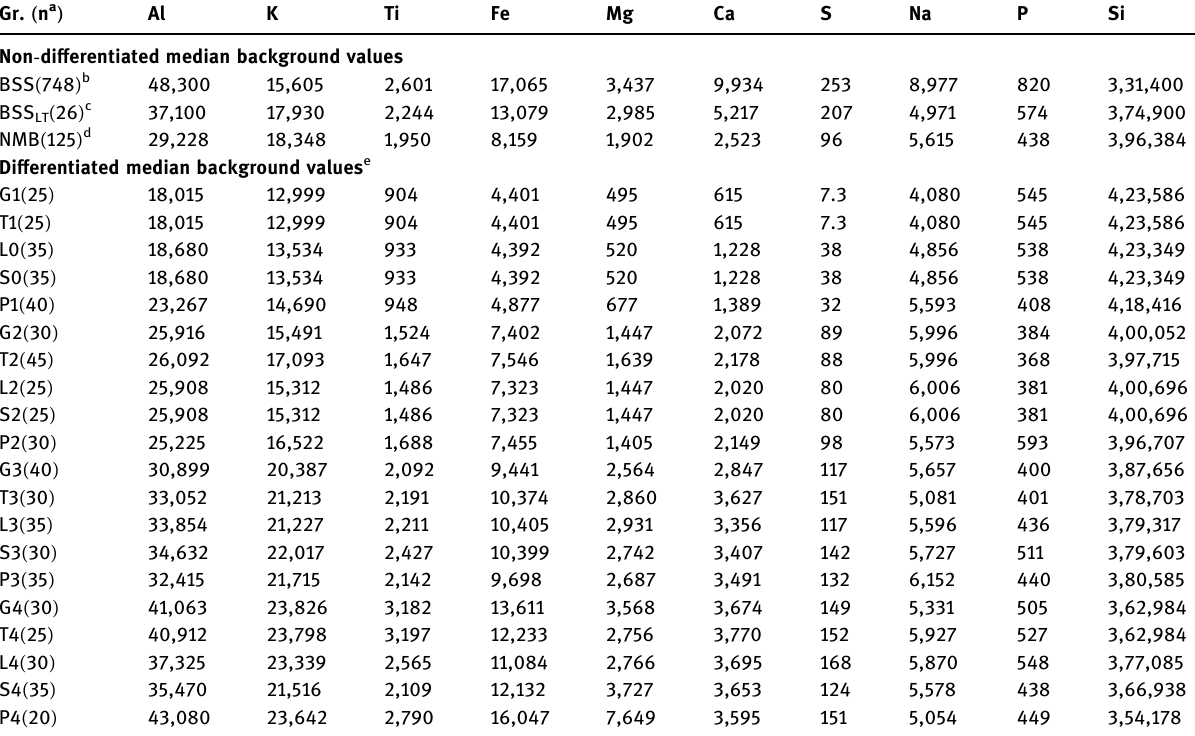
Table 5: Non - di ff erentiated and di ff erentiated median background values ( mg kg − 1 ) of major elements compared to non - di ff erentiated values obtained during the Baltic Soil